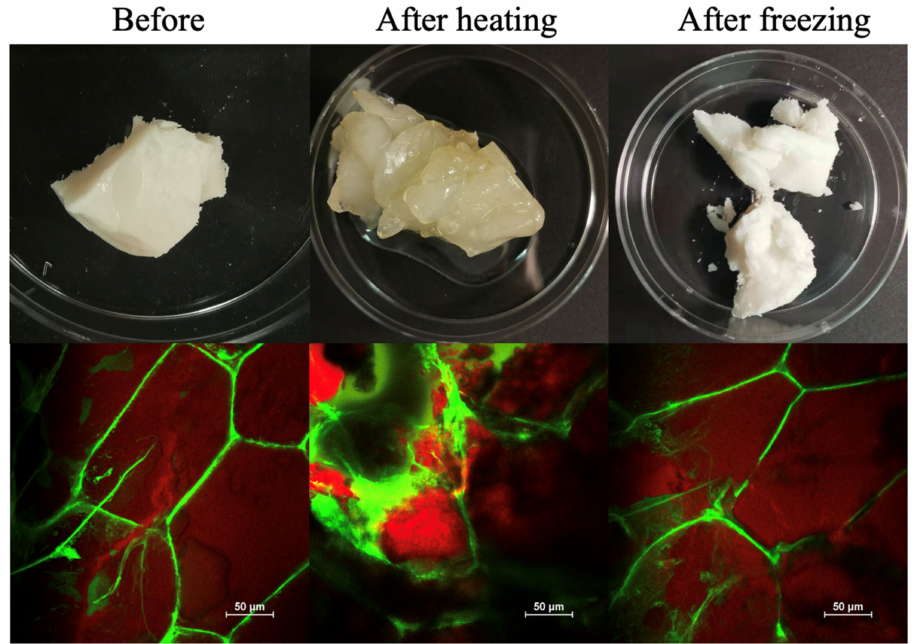
Figure 5. Appearance and microstructure of beef adipose tissue before and after heating and freezing for 24 h and then being brought to ambient temperature for 30 min before